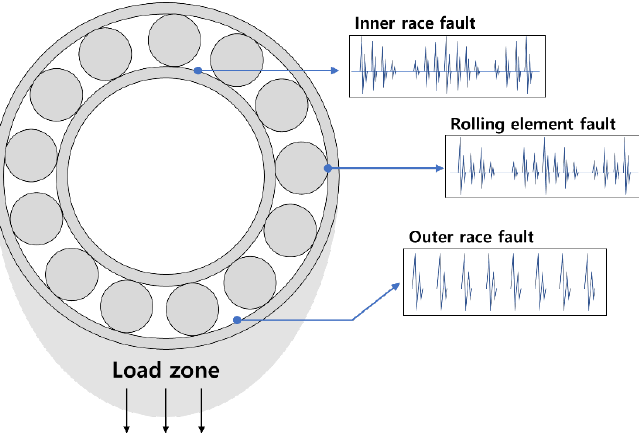
Figure 3. Examples of the ideal signals for each type of bearing fault.